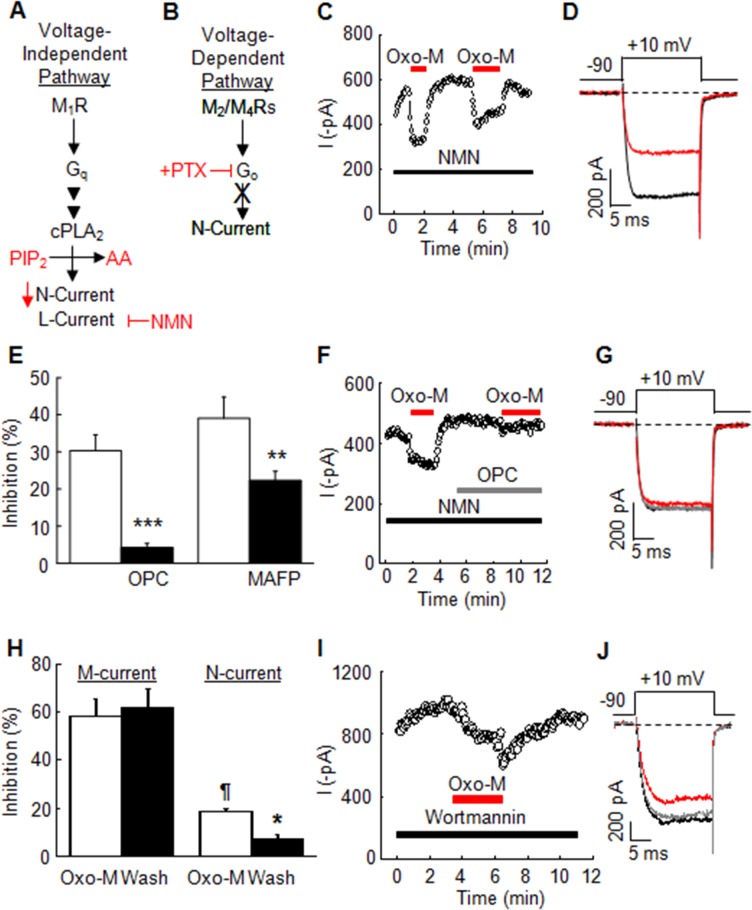
PLA2 antagonists reduce N-current inhibition by Oxo-M in neonatal rat SCG neurons.(A and B) Schematics showing the two muscarinic signaling pathways in SCG neurons along with the antagonists used that resulted in isolation of N-current by the slow pathway. Control inhibition by 10 μM Oxo-M is illustrated in the plot of current amplitudes vs time (C) and in the individual sweeps (D) taken from the time course of a perforated-patch recording. NMN (1 μM) was included in the bath to block L-current. (E) Summary of effects of PLA2 antagonists on N-current inhibition. OPC significantly reduces inhibition of perforated-patch N-current (***p ≤ 0.0015, n = 5) and MAFP (10 μM) significantly reduces inhibition of whole-cell N-current. **p ≤ 0.015, compared to inhibition by Oxo-M alone (open bars) using a two-tailed t-test for two means (n = 6–9). The presence of OPC (10 μM) in the bath for 3 min prior to challenging cells with Oxo-M blocks N-current inhibition, illustrated in a sample time course (F) and in individual traces (G) taken from the time course. (H) Summary of the effects of wortmannin on current inhibition by Oxo-M (open bar) and on current recovery following washout (black bars). M-current amplitude following Oxo-M washout does not recover. N-current inhibition is significantly different than in the absence of wortmannin (¶p ≤ 0.05, using a two-tailed t-test for two means when comparing to data in Fig 1E). Significant N-current recovery occurs following washout (*p ≤ 0.03, two-way t-test for two means) (n = 3–9). Example time course (I) and individual traces (J) of the reversible N-current inhibition by Oxo-M in the presence of wortmannin.